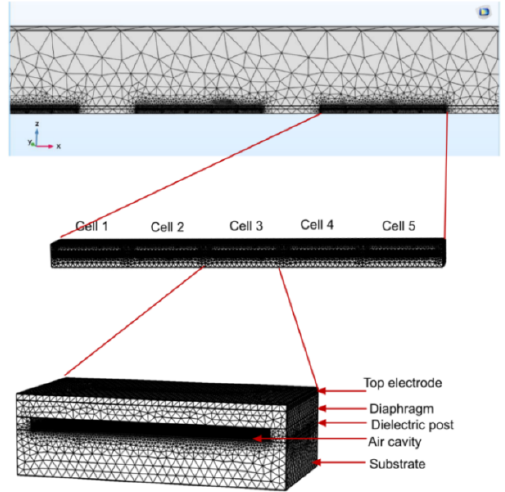
Figure 4. Simulation model of the capacitive micromachined ultrasonic transducer (CMUT) array in COMSOL™ [21].